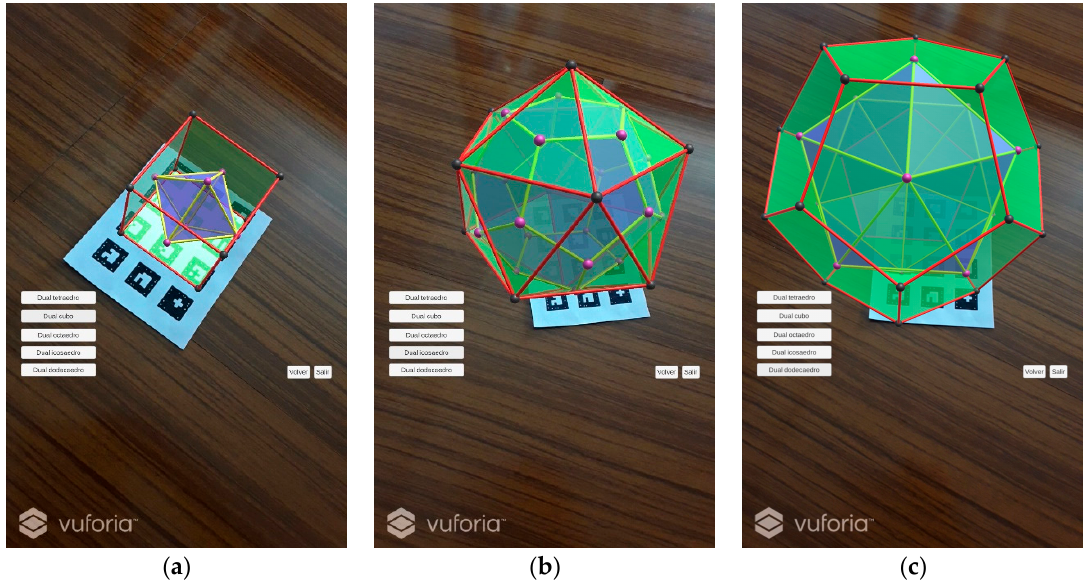
Figure 7. Images of dual polyhedra with AR. ( a ) Octahedron dual polyhedron; ( b ) and ( c ) Dodecahedron dual polyhedron.